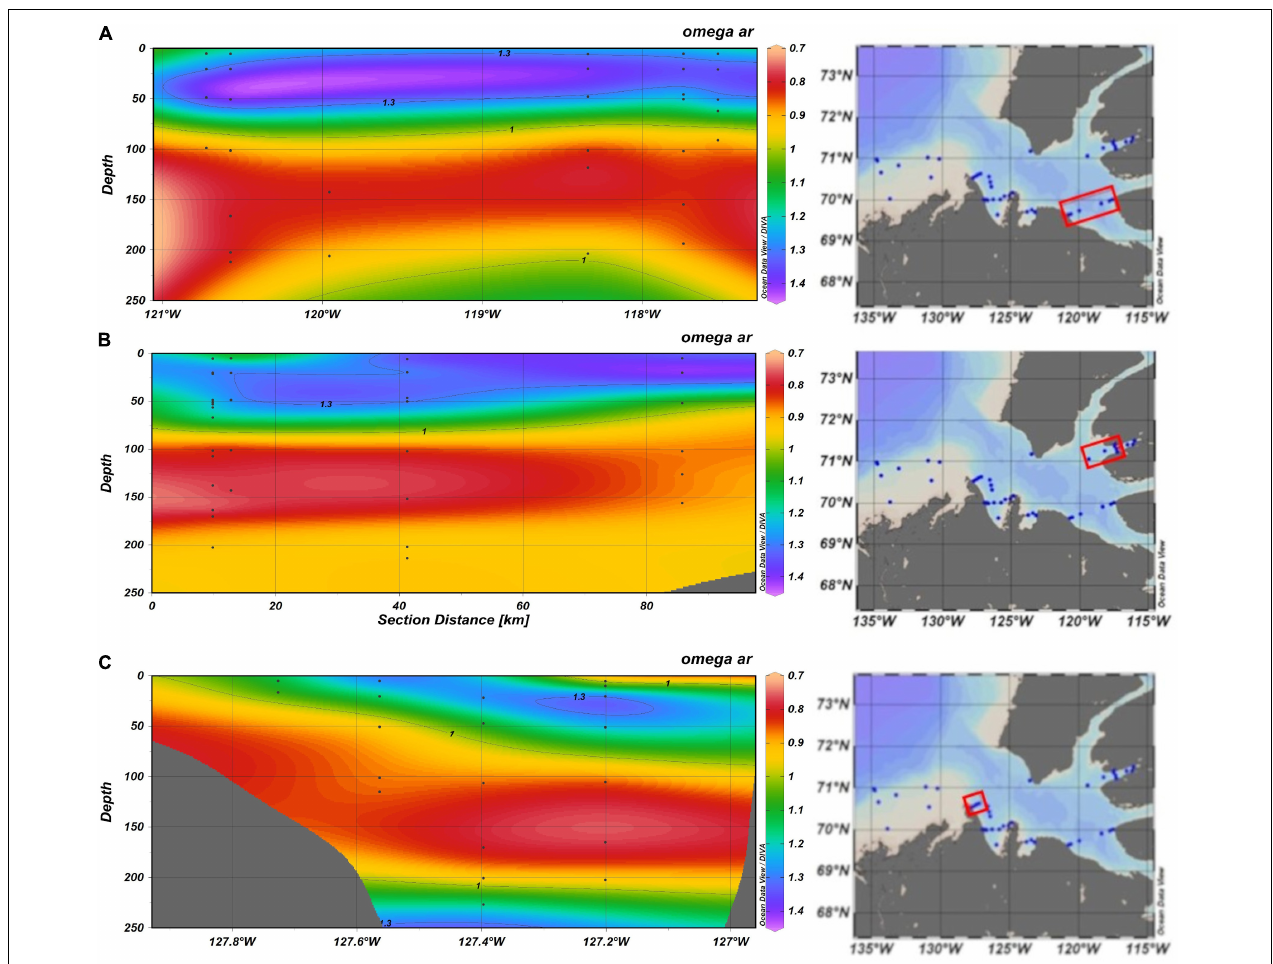
FIGURE 9 | Transect plots of aragonite saturation state ( (cid:127) ar ; based on the observational data) in the Amundsen Gulf in the Canadian Arctic sampled in August 2018. Transects extend across Dolphin and Union Strait (A) ; Minto Inlet (B) and across the mouth of the Gulf from Cape Bathurst (C) . Red boxes on the transect maps include the biological stations investigated for pteropod shell dissolution (previously published in Niemi et al.,